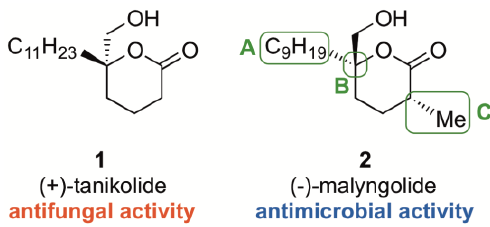
Figure 1. (+)-Tanikolide and ( − )-malyngolide.